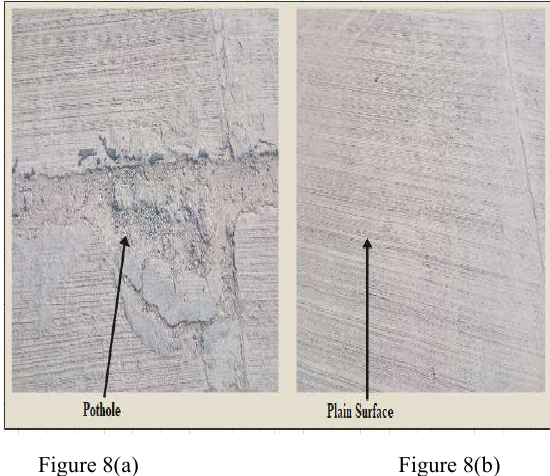
Figure 8 . Actual image of road surface data with & without potholes.